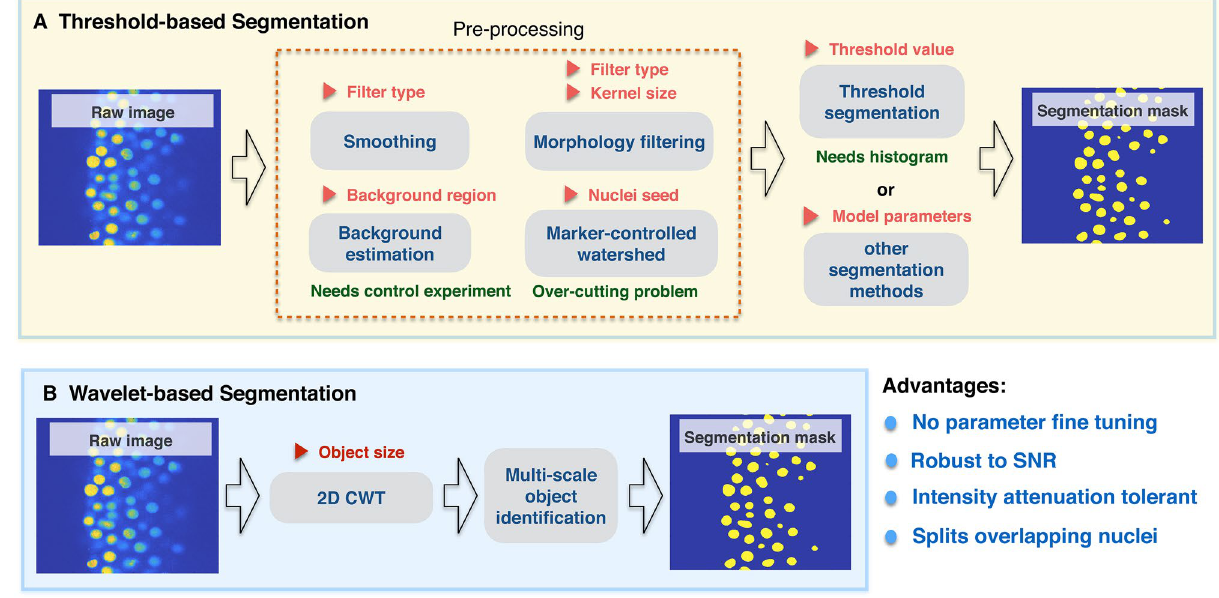
Figure 1. Comparison between threshold-based segmentation and wavelet-based segmentation methods. Preprocessing steps are crucial for most threshold-based segmentation methods and determine the quality of segmentation performance. Increased parameter numbers in preprocessing steps and segmentation method increases result complexity. Red triangle symbols indicate parameters required for each step and may need parameter fine